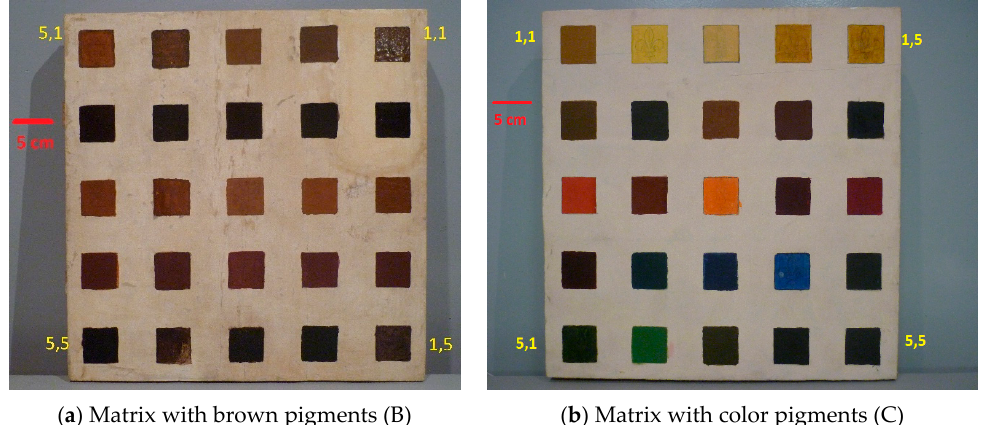
Figure 2. Pigment matrices: for color pigments (C) and for brown pigments (B). On B, each column on each matrix features a different pigment and each row features a different substrate. On C, each row is a different pigment and each column a different substrate. On some elements, the under- drawing even in the visible is noticeable. This is quite apparent for the color matrix, elements